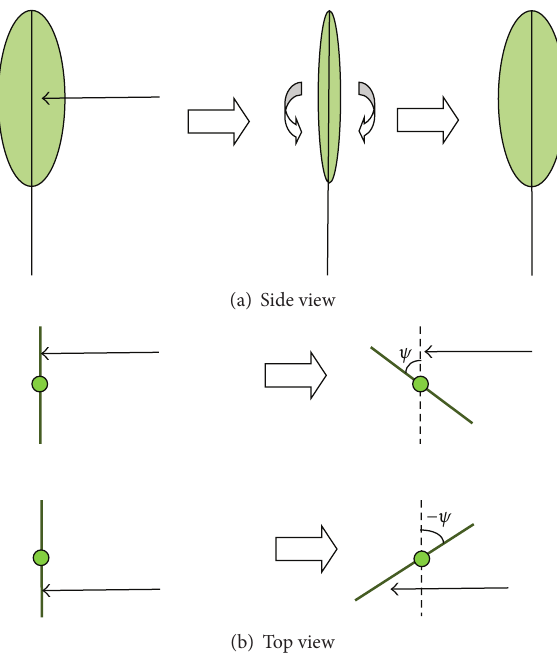
Figure 7: Leaf twisting in response to wind.